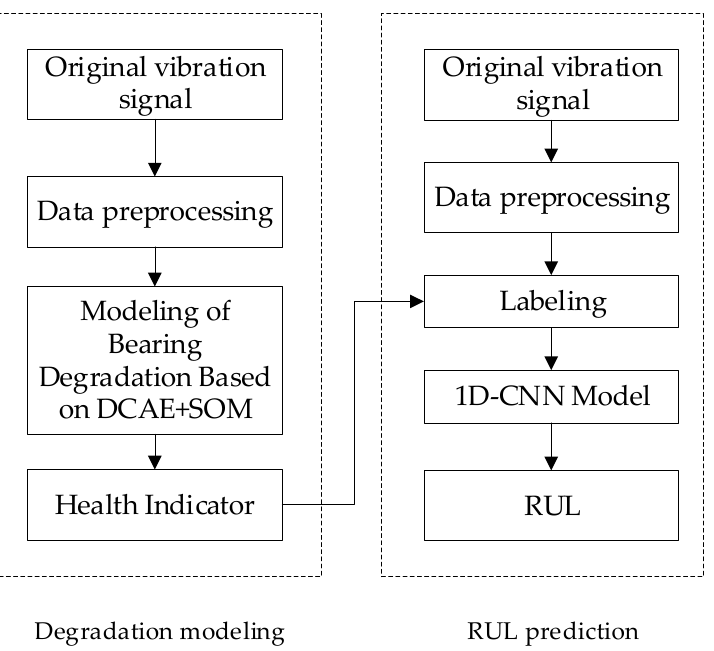
Figure 1. RUL prediction process of rolling